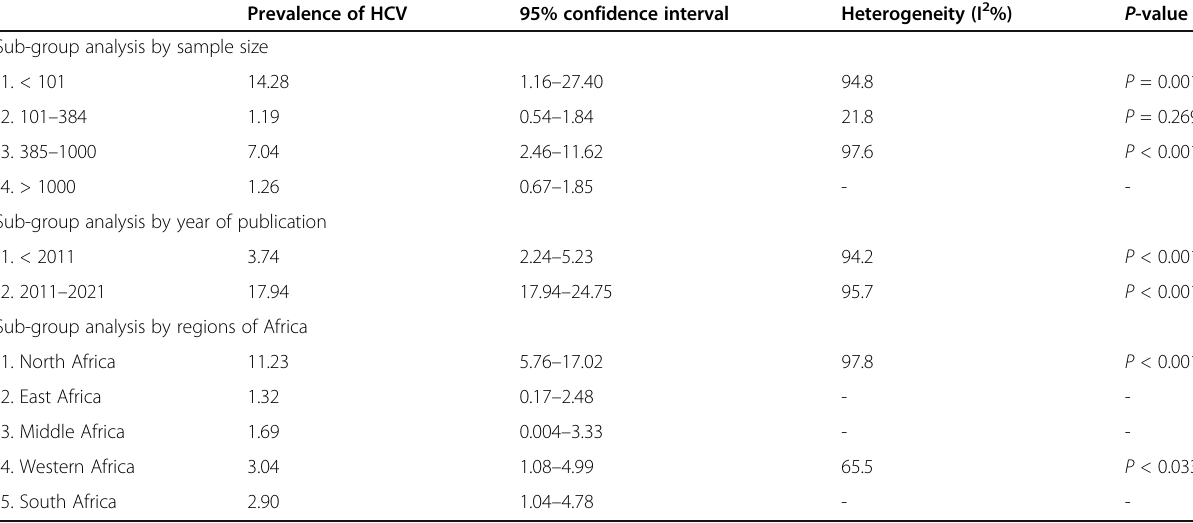
Table 5 Showing sub-group analysis of HCV prevalence by sample size, year of publication, and sub-regions of African countries Prevalence of HCV